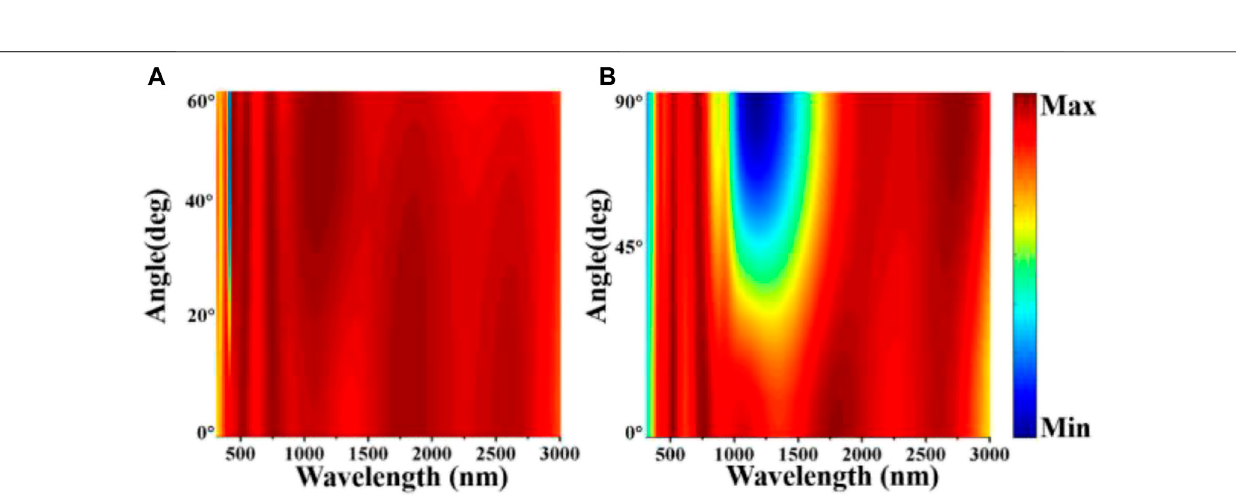
the Figure 4 . The distribution of electric fi eld and magnetic fi eld at the wavelength of 500 nm, 1,500 nm and 2,500 nm of the incident light are plotted with the interval of 1,000 nm. The selected plane is xoz plane, and the top layer of ITO antire fl ection layer and GaAs grating layer are indicated with black dotted line.